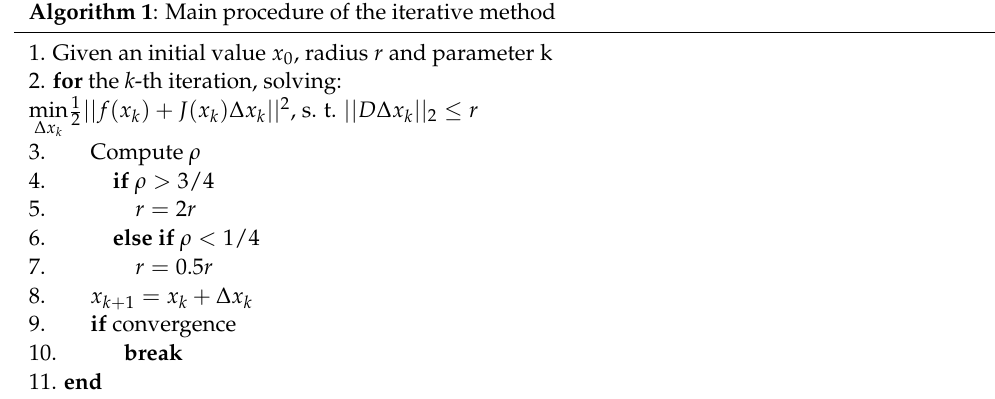
Algorithm 1 : Main procedure of the iterative